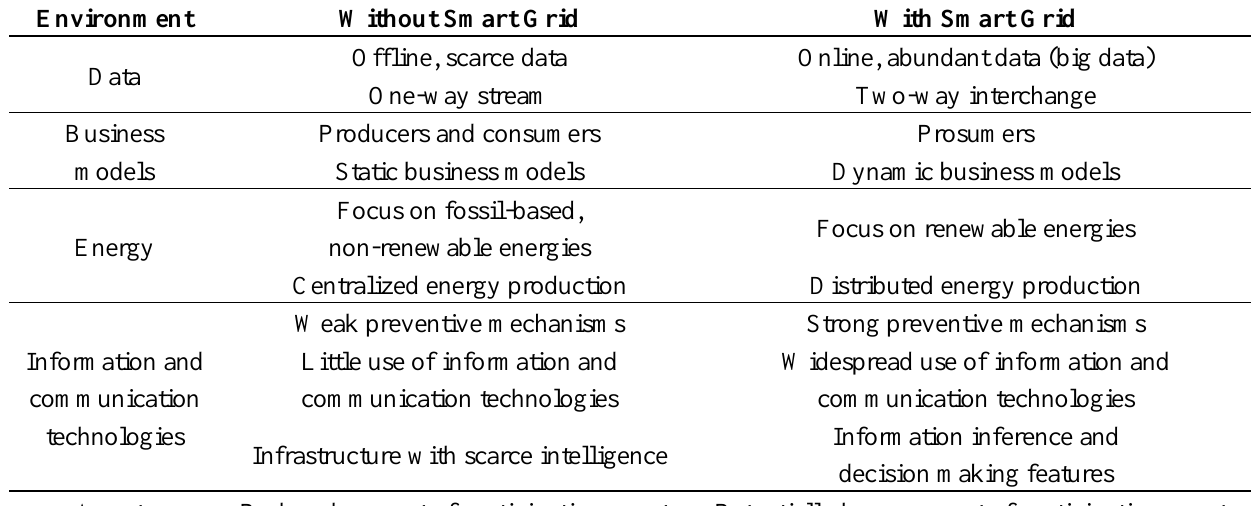
Table 1. Comparison between features with and without the smart